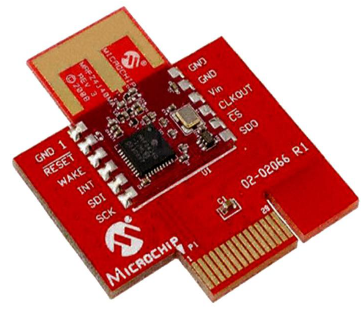
Figure 4. Zigbee radio